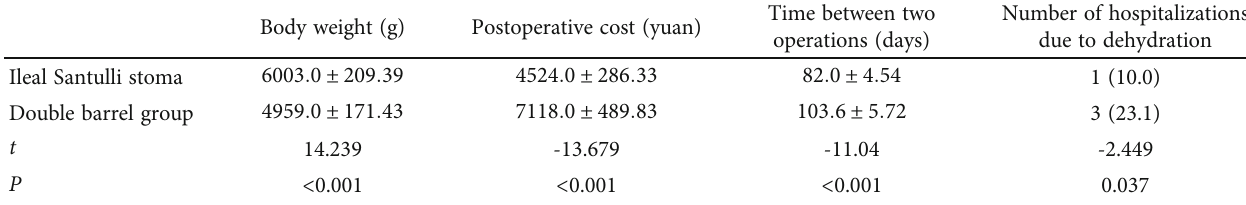
Table 2: Comparison of results between the two groups of